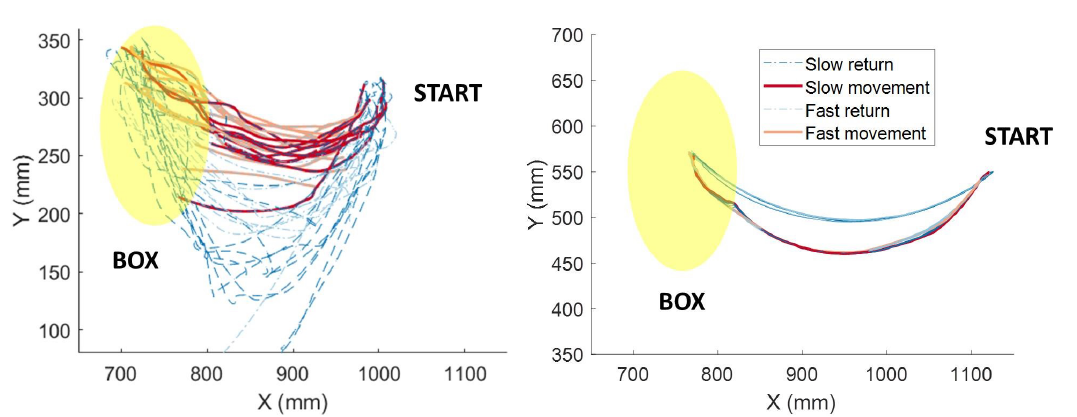
Figure 3: Trajectories of one representative subject (left) and the robot (right) during the “Robot Fast” and “Robot Slow” conditions. The plot refers to an Italian subject but is also representative for the behavior of Japanese participants. X and Y axis are a projection of the 3D space in the frame of reference of the motion capture system.